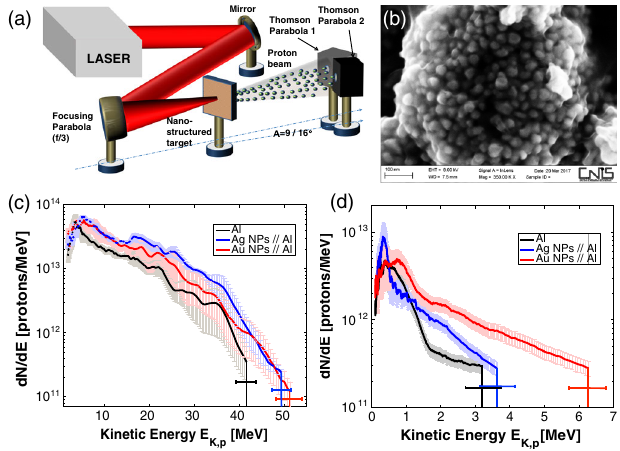
FIG. 1. (a) Experimental setup. (b) Scanning electron micro- scope (SEM) image of gold NPs deposited onto a planar 15 μ m Au foil target. (c) Proton spectra with error bars obtained on the TITAN laser with Ag (blue curve) and Au NPs (red curve) on Al foils compared to a standard 15 μ m Al foil (black curve). (d) Proton spectra obtained on the ELFIE laser with Ag (blue curve) and Au NPs (red curve) on Al foils compared to a standard 15 μ m Al foil (black